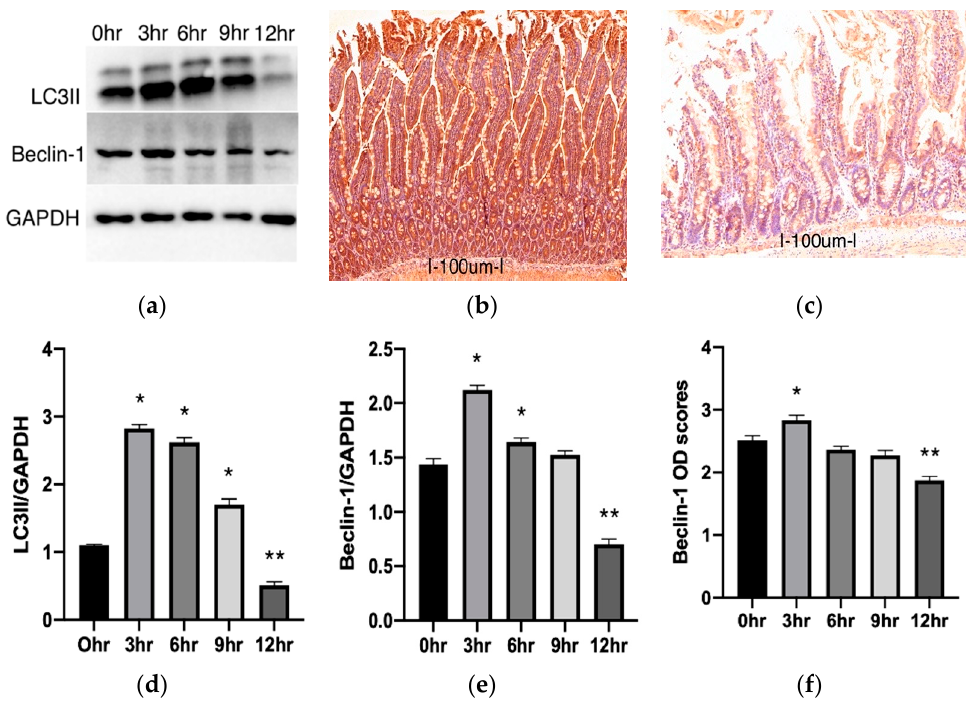
Figure 3. Changes of autophagy in intestinal mucosa. Panel ( a ) shows representative electrophoresis patterns for LC3II and Beclin-1. Panels ( b , c ) are representative of immunostaining for Beclin-1 at 0 h ( b ) and 12 h ( c ). Scale bar: 100 µ m; Mg: 14.0x. Panels ( d , e ) show changes in LC3II and Beclin-1, respectively, with time. Each protein is represented as a ratio of GAPDH. Panel ( f ) illustrates changes in optical density (OD) scores for Beclin-1 immunostaining. Data are mean ± SEM, n = 6. * p < 0.05 increase versus the 0 h group (operated control). ** p < 0.05 decrease versus the 0 h group.